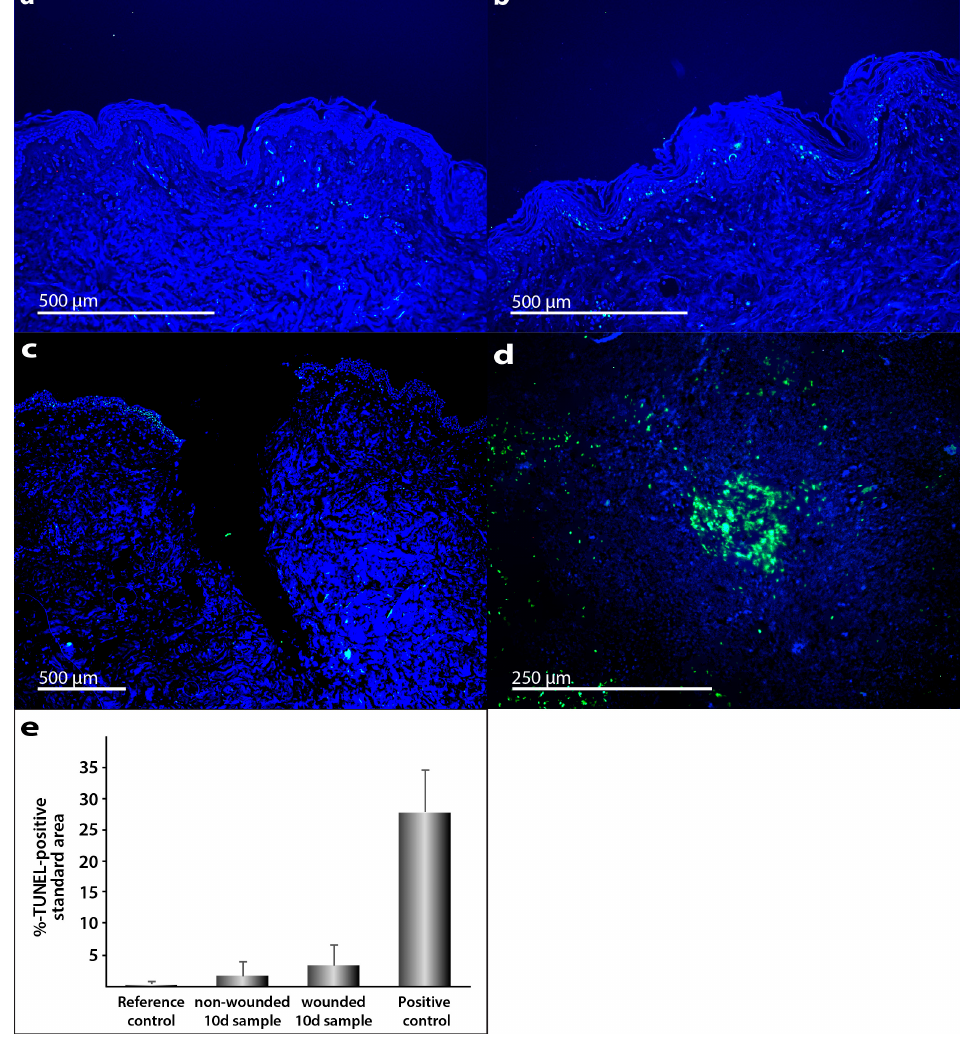
Figure 3. Detection of apoptosis in human full-thickness skin graft cross sections: TUNEL staining